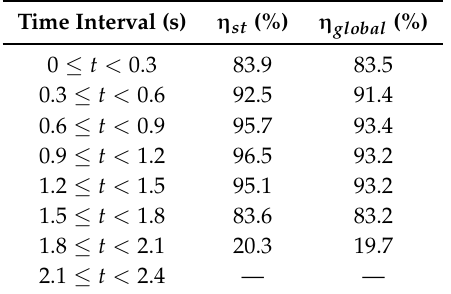
Table 6. Efficiencies calculated in the G2V